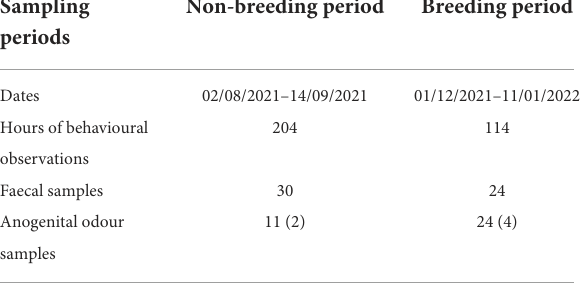
TABLE 2 Overview of the data